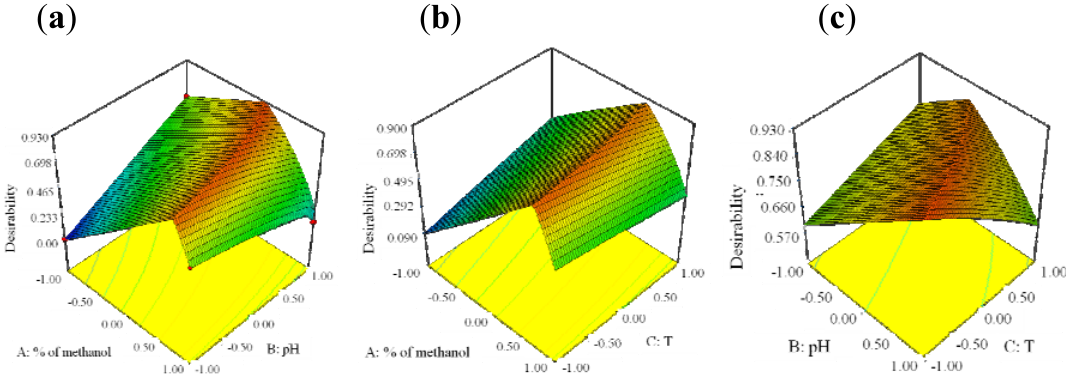
Figure 6. 3-D plots of the Derringer’s desirability function in correlation with a variation of methanol content and pH ( a ), methanol content and temperature ( b ) and pH of mobile phase and temperature of column ( c ).